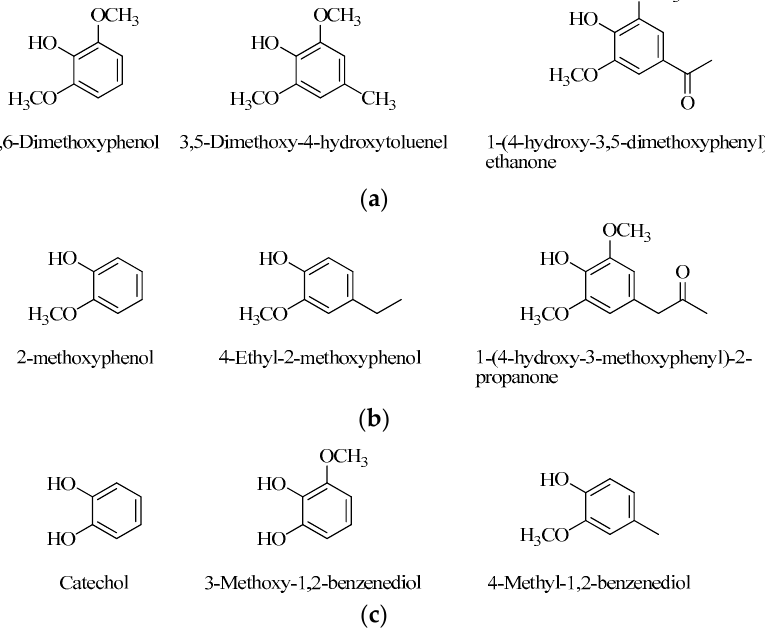
Figure 4. Molecular structures of the phenol compounds from the wood vinegar ( a ) syringol-type, ( b ) guaiacol-type, and ( c ) benzenediol-type.